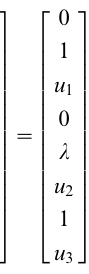
while the velocity in the x { direction decreases correspondingly. The wall velocity gradients f 00 (0), g 00 (0) and entrainment velocity f ( ? ) z g ( ? ) as functions of stretching rates ratio l have been plotted in Fig. 5. Due to the bi-directional stretching sheet, there will be downward flow in the vertical direction. The vertical component at far field boundary is therefore expected to be negative in this situation. We notice that shear stresses at the wall increase when l is increased. Further, the larger values of l enhances the velocity of the cold fluid at the ambient. As a consequence, the entrainment velocity is an increasing function of l . Fig. 6 indicates that temperature h decreases with an increase in stretching rates ratio l for unity Prandtl number. Physically, an increase in l enhances the intensity of colder fluid at the ambient (as noticed in Fig. 6) towards the hot sheet which eventually corresponds to decrease the local fluid temperature. Fig. 7 perceives the behavior of Prandtl number Pr on the temperature. A bigger Prandtl number fluid has less thermal diffusivity and hence it allows less thermal effect to penetrate deeper into the fluid. As a result, temperature decreases and the thermal boundary layer becomes thinner when Pr is increased. This decrease in thickness of the thermal boundary layer is compensated with a larger wall slope of temperature function. Fig. 8 plots the wall temperature gradient against Pr with the variation in stretching rates ratio l . The wall heat transfer rate approaches the zero value for vanishing Prandtl number Pr ? 0 , a fact that is clear from the energy equation (9). Moreover, this Fig. compliments the results of Fig. 4. In bigger Prandtl number fluids the convection is effective in transferring energy from the stretching sheet compared to pure conduction. Due to this reason the wall heat transfer rate is an increasing function of Pr . The reduction in thermal boundary layer thickness with an increase in l meets with the bigger magnitude of local Nusselt number. In other words the enhanced intensity of cold fluid at the ambient